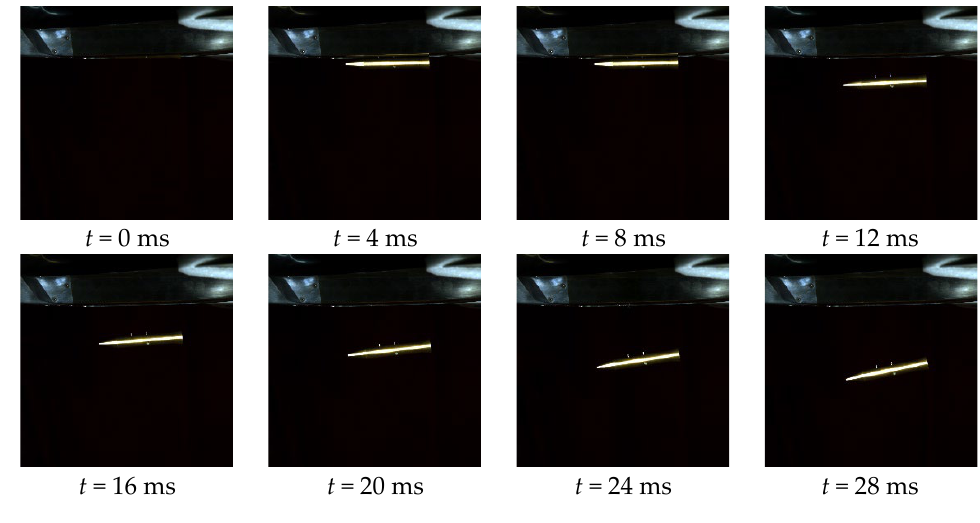
Figure 7. Test results for no jet and no wind.